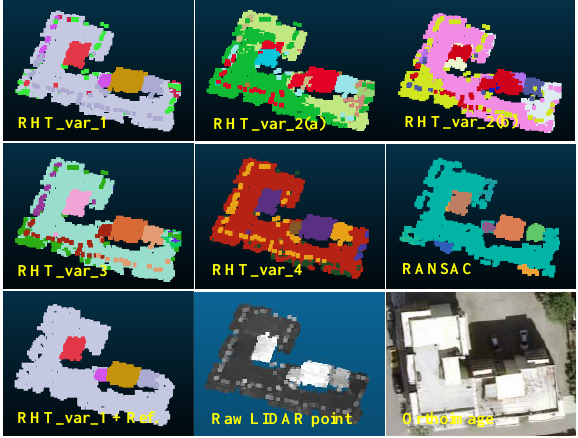
Figure 4. Plane detection of Building 1 using the variations of the RHT and RANSAC.